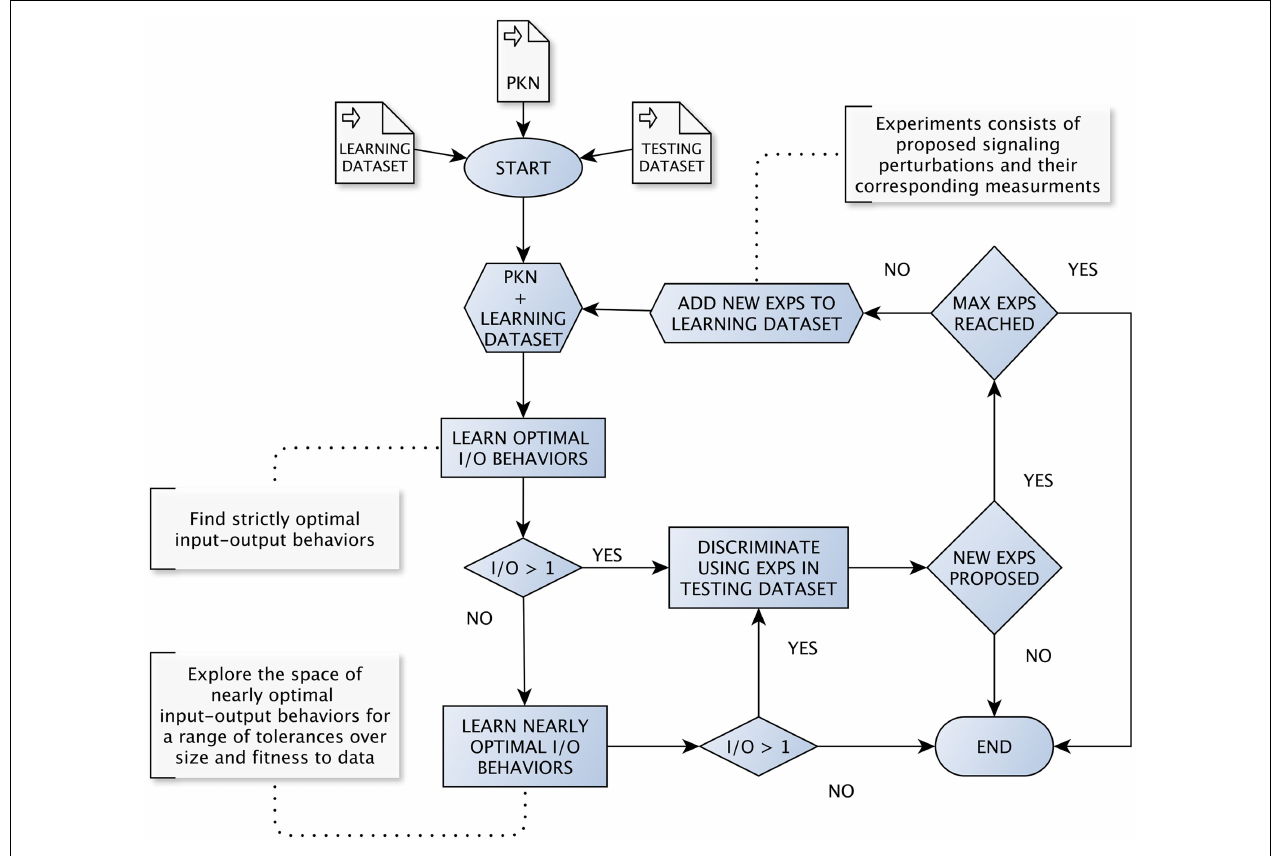
is proposed. Next, both the set of perturbations and the corresponding measurements are added to the dataset used for learning and the loop starts over. When the learning method returns a single optimal input–output behavior, the workflow explores nearly optimal behaviors by considering a range of tolerances, first over the optimum model size and then over the optimum